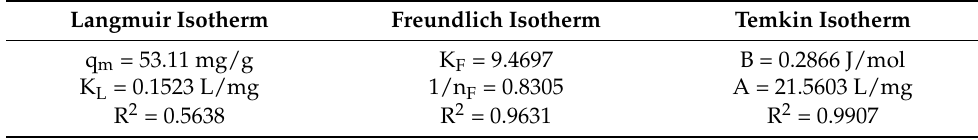
Table 1. Isotherm parameters.